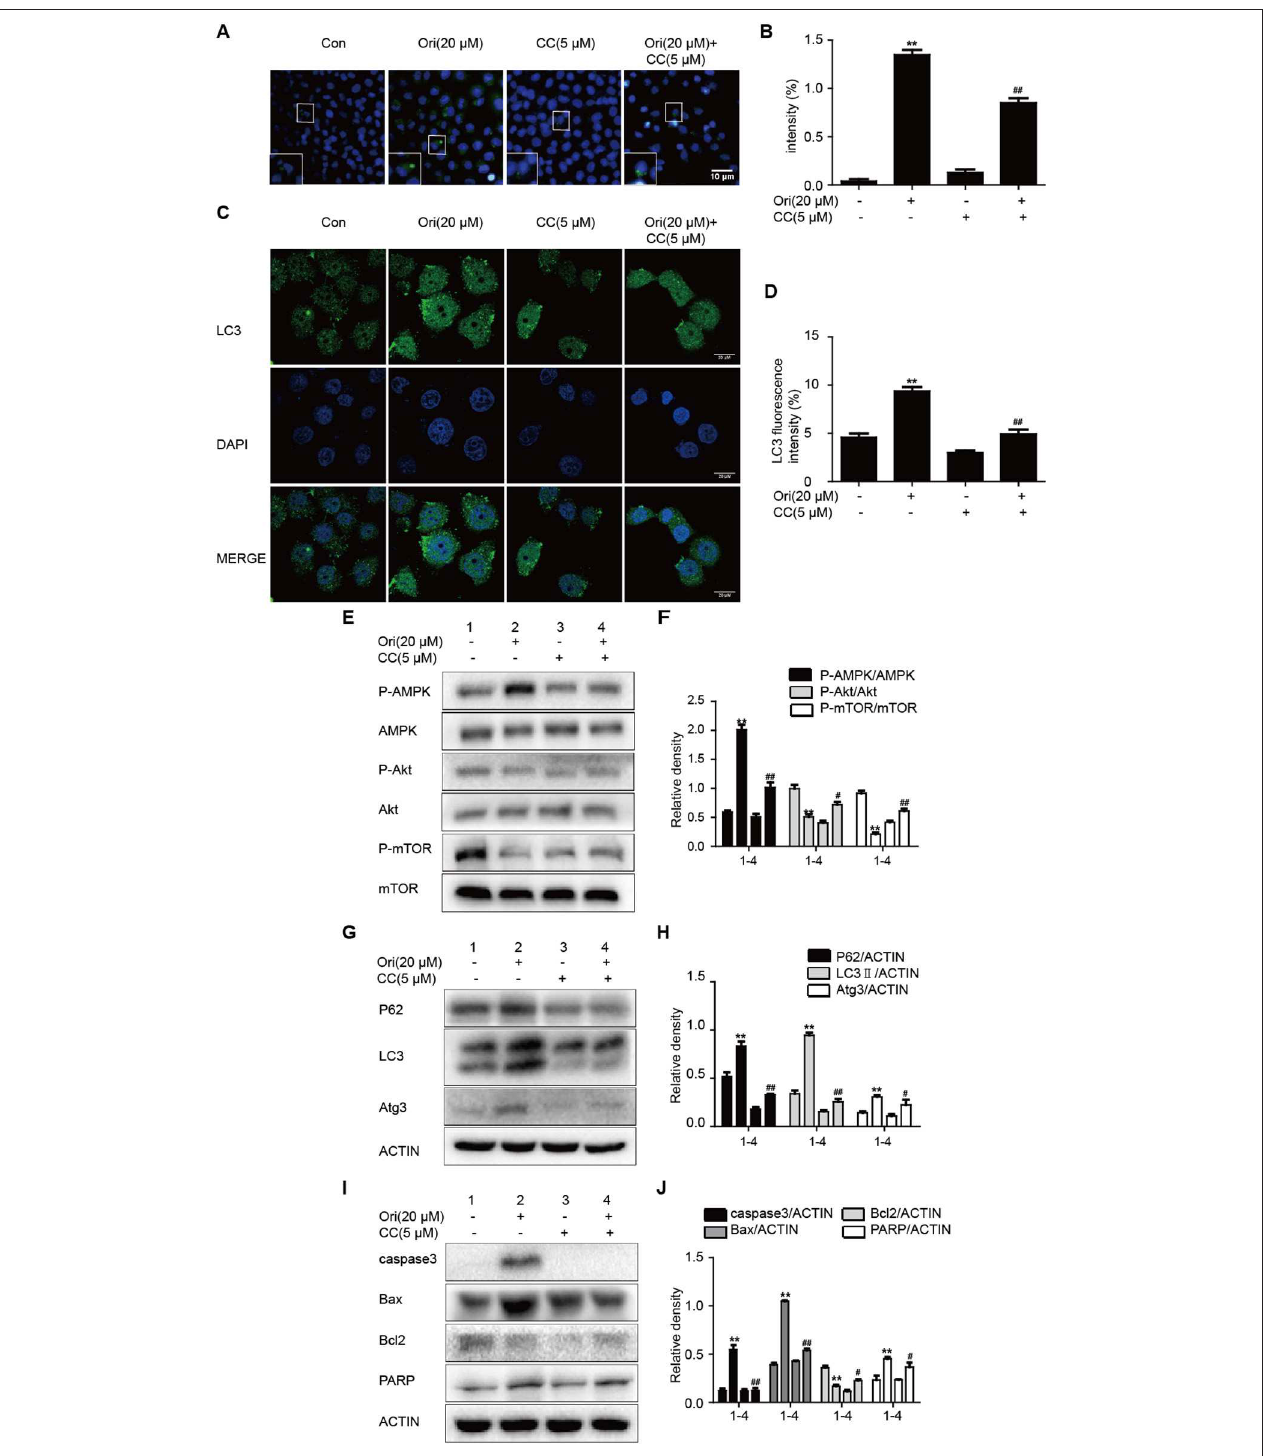
FIGURE 2 | Ori initiates autophagy, apoptosis and Akt/mTOR signaling by the regulation of AMPK. Cells were treated with Ori (20 µ M) in the absence or presence of compound c (5 µ M) for 18h. (A,B) Cells were stained with an autophagosome specific green reagent and examined by fluorescence microscope. The green fluorescence intensity was analyzed by Image J. Scale bars: 10 µ M. (C,D) Cells were stained with LC3 and DAPI and images were captured with confocal microscope. The LC3 fluorescence intensity was analyzed by Image J. Scale bars: 20 µ M. (E–J) Western blots and statistical results showed the protein levels of P-AMPK, AMPK, P-Akt, Akt, P-mTOR, mTOR, P62, LC3, Atg3, caspase3, Bax, Bcl2, and PARP. The results showed the average of three independent experiments. ** p < 0.01 vs. the control group. # p < 0.05 and ## p < 0.01 vs. the Ori group.